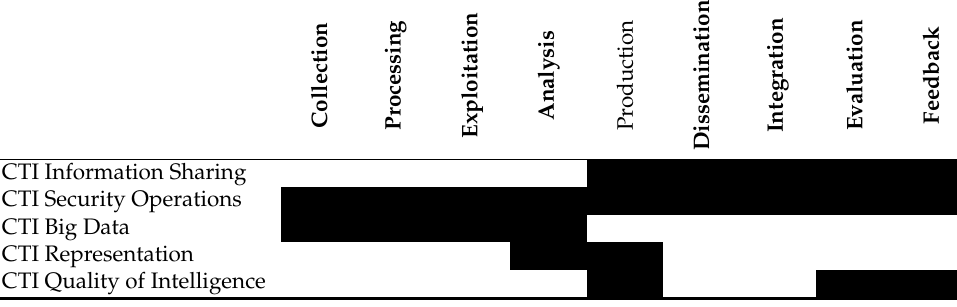
Table 2. CTI complexity factors categories concerning CTI frame of